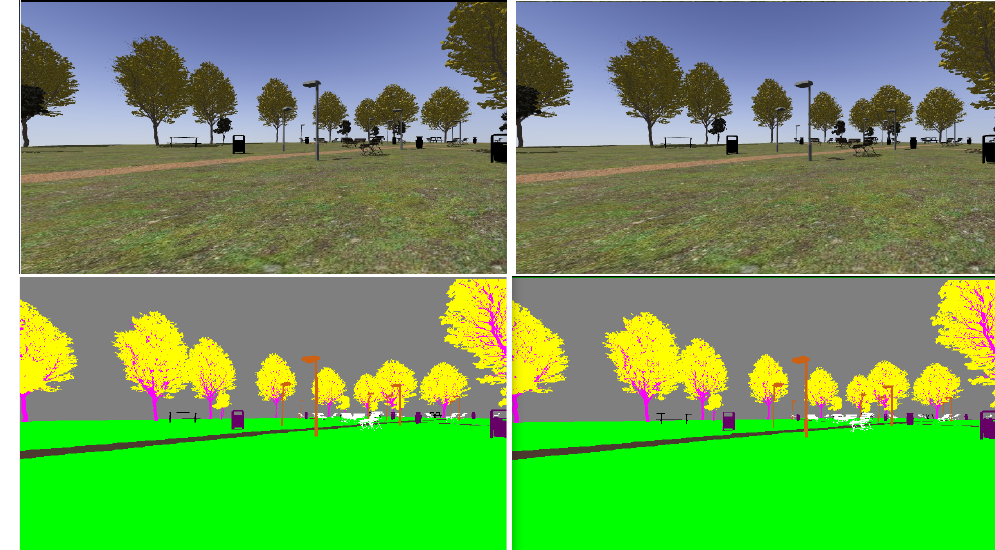
Figure 17. Realistic ( up ) and tagged ( down ) stereo image pairs ( left-right ) taken from the park